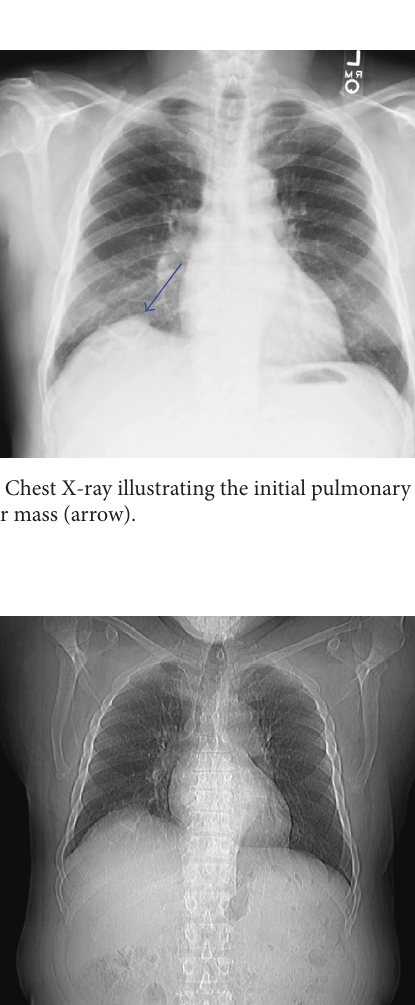
Figure 1: Loculated liver mass, as soon on admission CT.